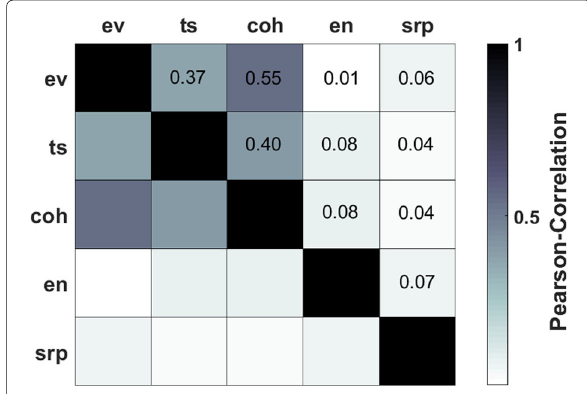
Fig. 8 Pearson correlation coefficients between the room